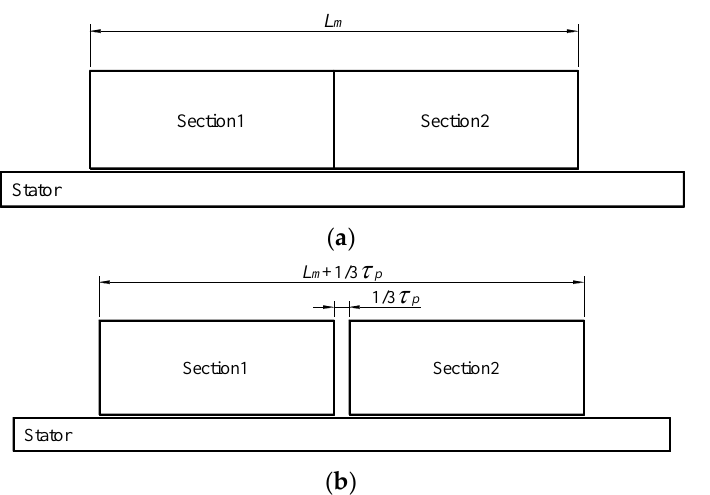
Figure 1. Schematic of teeth arrangement design: ( a ) without teeth arrangement design; ( b ) with teeth design.